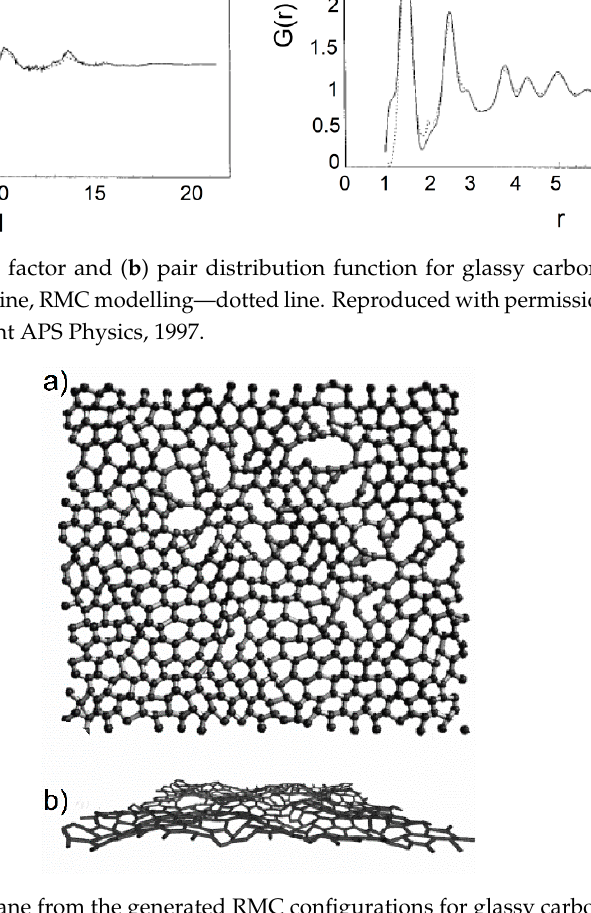
Figure 21. ( a ) A basal plane from the generated RMC configurations for glassy carbon heat-treated at 1000 °C. ( b ) A side-on view of the same basal plane. Reproduced with permission from O’Malley and